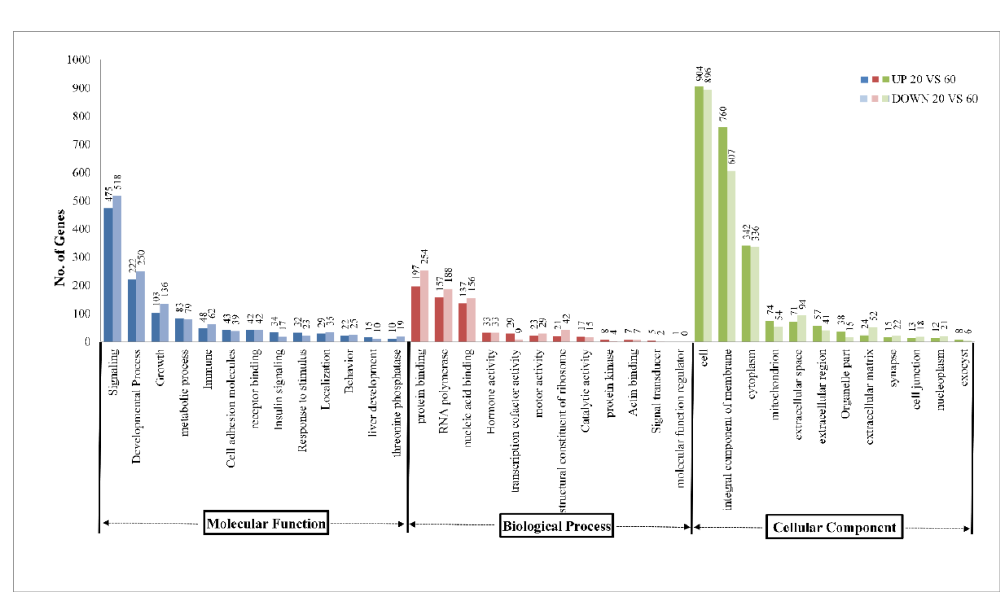
Figure 3. Gene ontology distribution (CHO ‐ related) for the molecular function, biological process and cellular component, of ( A ) Control versus fishes fed with 40% CHO, and ( B ) control versus fishes fed with 60% CHO. The y ‐ axis indicates the number of genes annotated to one GO term. The up ‐ regulated genes under Molecular Function are shown as blue and light blue represents down ‐ regulated genes, biological process up ‐ regulated genes are shown as red and down ‐ regulated genes are shown as light red, and cellular component genes are shown in green for up ‐ regulation and light green for down ‐ regulation.